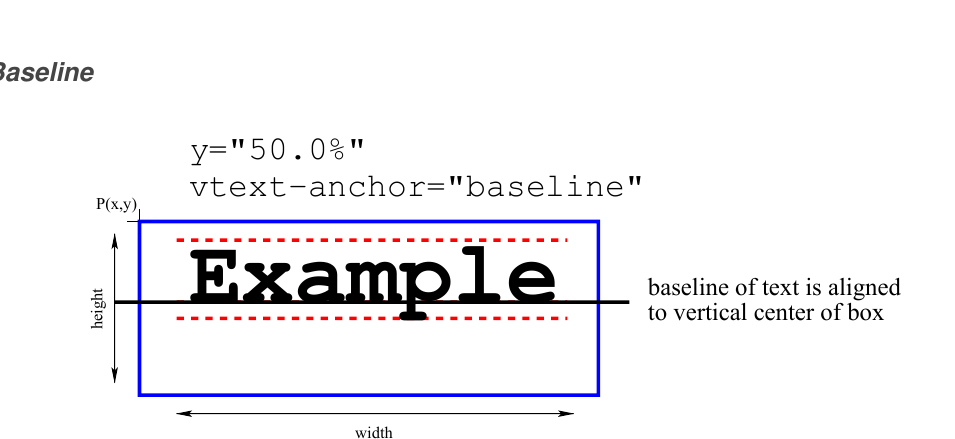
Figure 19: vertical text alignment middle